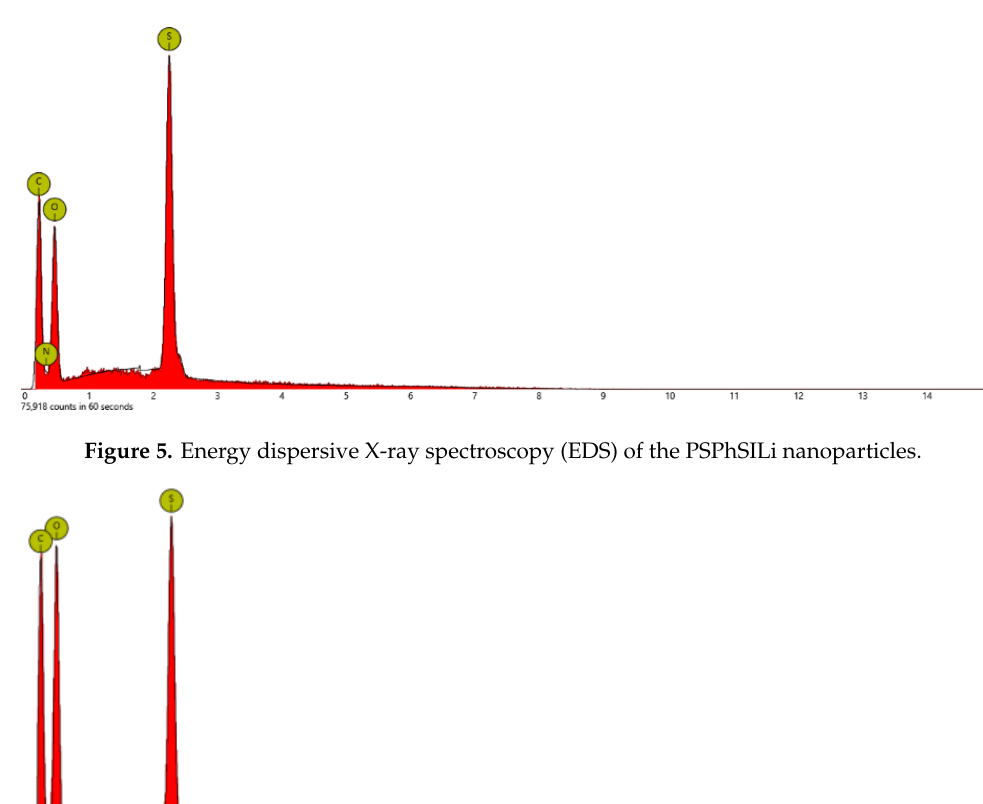
Figure 4. Energy dispersive x-ray spectroscopy (EDS) of the PSTFSILi nanoparticles.